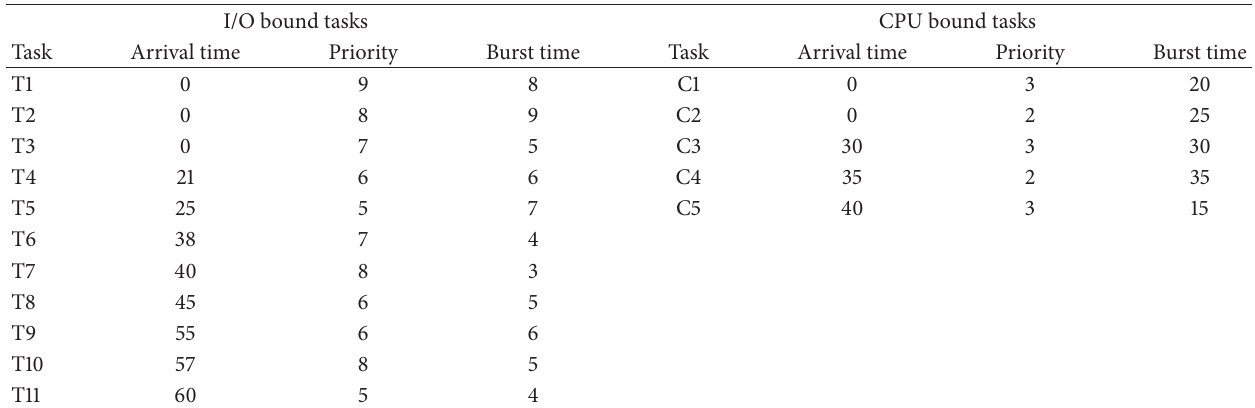
Table 1: Sample task